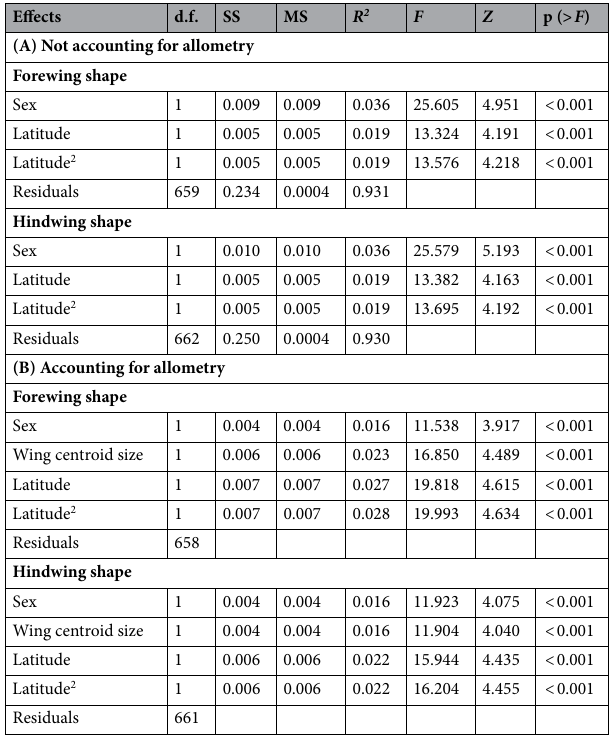
Table 3. (A) Results for the Procrustes ANOVAs investigating the effects of latitude and sex on fore- and hindwing shape of Lestes sponsa . (B) Results for the Procrustes ANOVAs investigating the effects of latitude, size (measured as wing centroid size) and sex on fore- and hindwing shape of Lestes sponsa